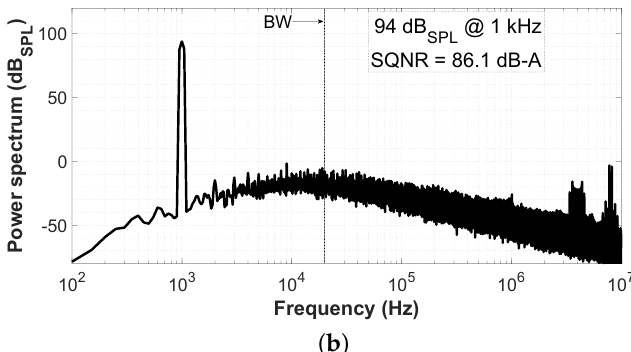
Figure 6. Simulated spectrum for an input signal of 94 dB SPL at 1 kHz: ( a ) Non-A-Weighted; ( b )